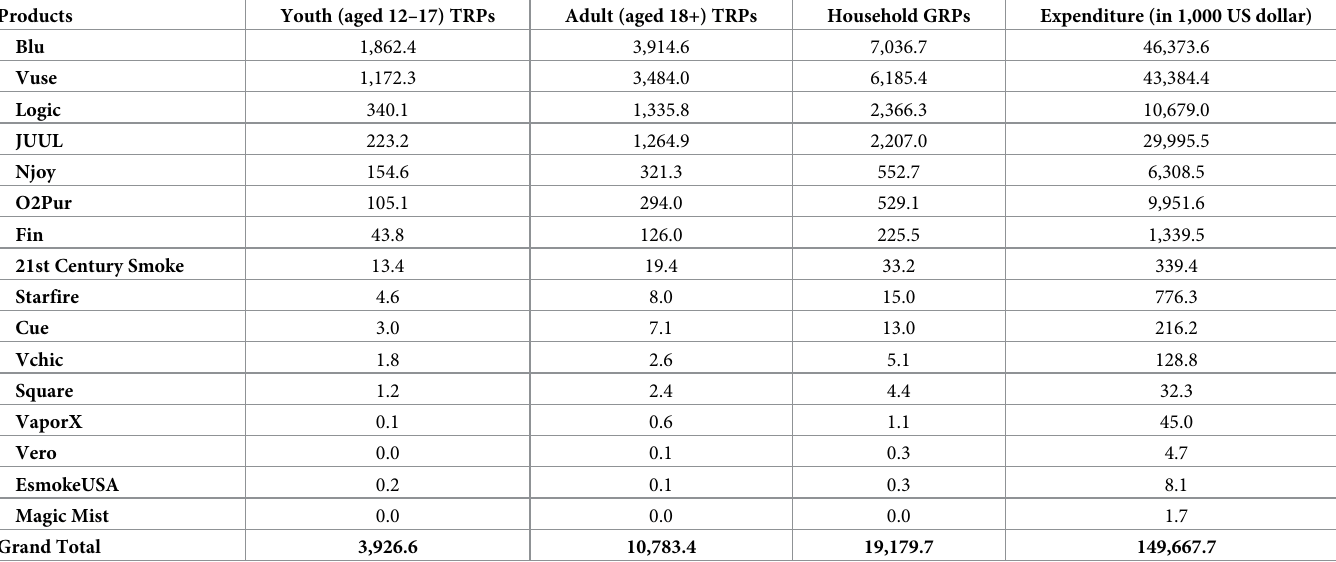
Table 1. TV ratings overall and by age groups and televised advertising expenditures of the top 20 advertised e-cigarette brands, 2013 to 2019.